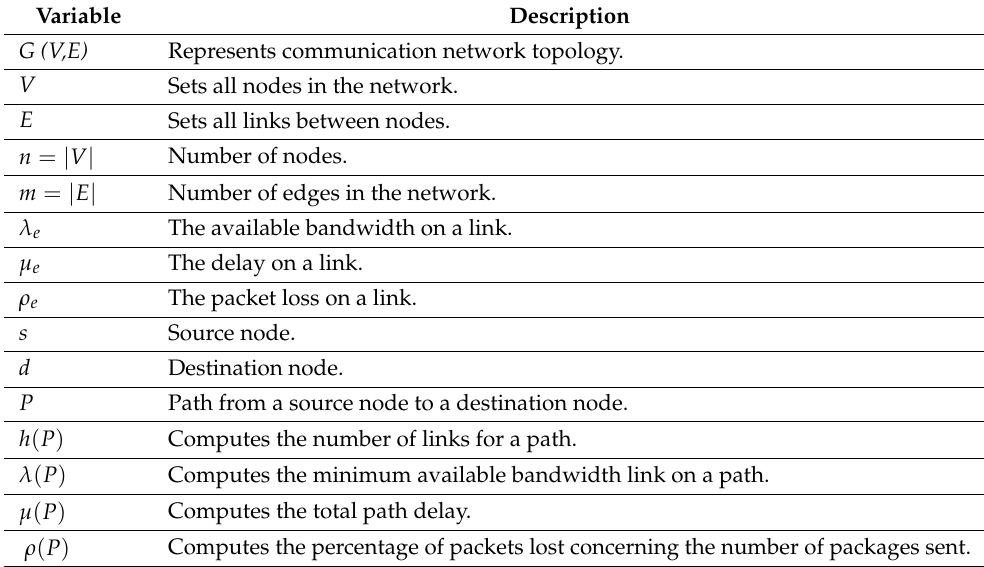
Table 2. Description of the network parameters